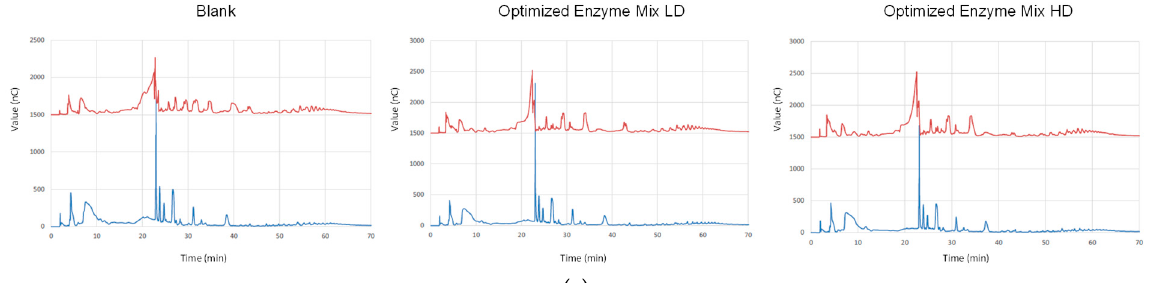
Figure 1. Digestion characteristics of the individual FODMAP components in upper GIT simulations with synthetic food substrates ( a ) and complex food substrates ( b ) and qualitative FOS profiling dur- ing upper GIT passage (complex food substrates) ( c ). During upper GIT simulations, levels of various products of FODMAP digestion were determined at the start of the gastric phase (gray bars) and at the end of the small intestinal phase (green bars) with no enzyme (blank) and those supplemented with the optimized enzyme mix (12.5 mg invertase [2500 SU], 100 mg β -galatosidase [10,000 ALU], 600 mg α -galactosidase [2400 GalU]). The synthetic food substrates included 2 g FOS, 5 g lactose, 0.5 g stachyose, and 0.5 g raffinose and the complex food substrates included 17.5 g each of industrial white bread, red kidney beans, and skim milk. For the qualitative FOS profiling, the blue line represents the qualitative FOS profiling determined at the start of the gastric phase and the red line represents the same at the end of the small intestinal phase. GIT = gastrointestinal; FODMAP = fermentable oligosac- charides, disaccharides, monosaccharides, and polyols; FOS = fructooligosaccharide; HD = high dose; LD = low